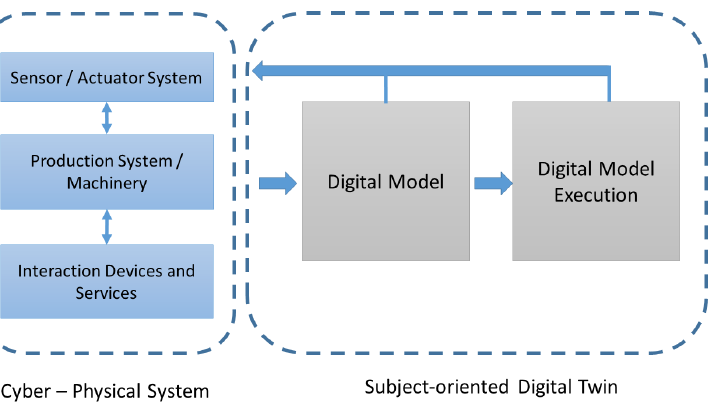
Figure 2. The digital twin thread concept for a CPS, based on modeling and execution, reprinted from (Ref. [8],